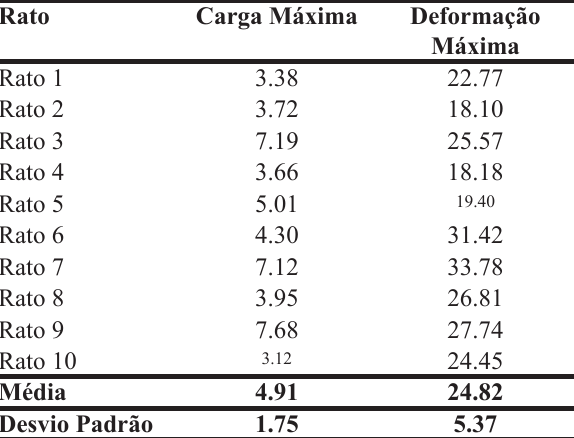
FIGURA 2 - Teste de tração. Legenda: A- Momento de posiciona - mento, sem tração. B- Momento de tração, ainda sem ruptura. C- Momento inicial da ruptura. D- Momento final de separação total dos cotos da